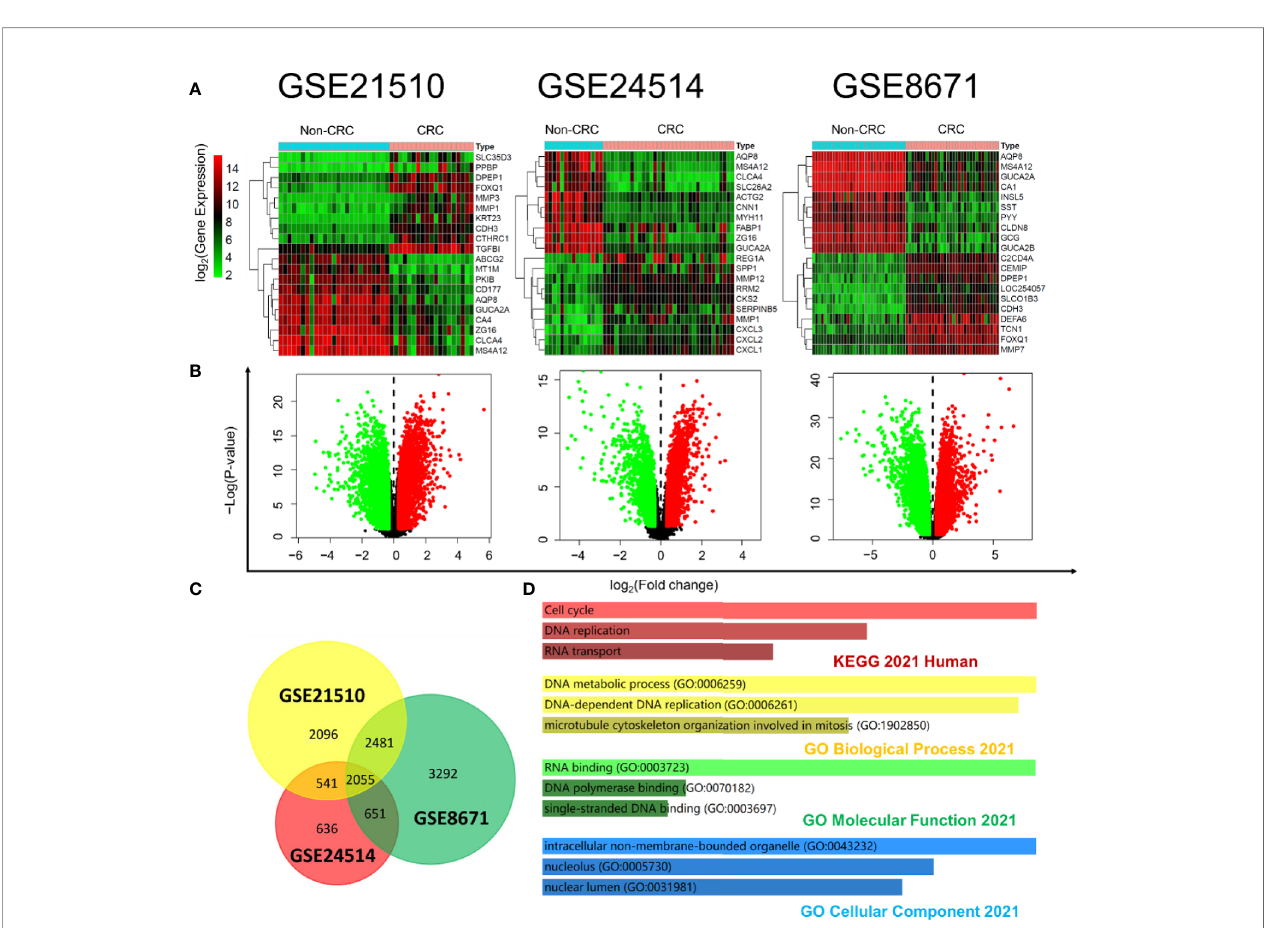
FIGURE 3 | DEG mining between non-CRC tissues and CRC tissues based on the GEO database. (A) Heatmap of the differential gene expression in all the samples from non-CRC and CRC at the datasets GSE21510, GSE24514, and GSE8671; the color bar represents differential gene expression magnitude. (B) Identi fi cation of the differentially expressed genes between non-CRC and CRC at the datasets GSE21510, GSE24514, and GSE8671. (The red and green spots in the CRC were classi fi ed by the upregulated and downregulated genes compared with non-CRC, respectively.) (C) Venn plot of DEGs at the datasets GSE21510, GSE24514, and GSE8671 (6,544 genes were mapped in 7,173 DEGs of GSE21510; 3,790 genes were mapped in 3,883 DEGs of GSE24514; and 7,446 genes were mapped in 8,479 DEGs of GSE8671). (D) KEGG pathways and GO functional analysis of overlapped DEGs at the datasets GSE21510, GSE24514, and GSE8671 based on the Enrichr online